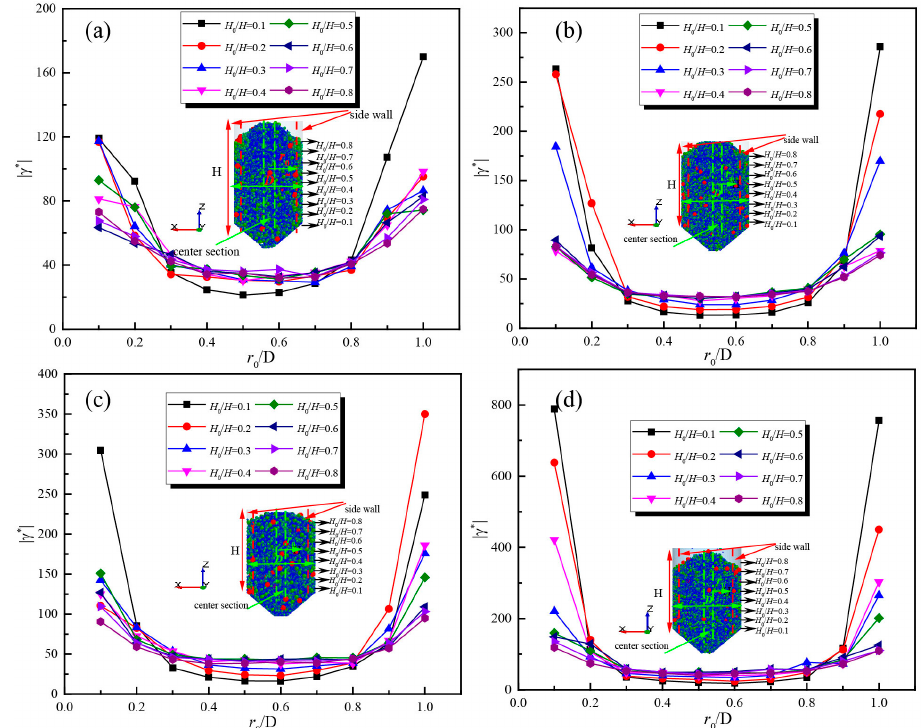
Figure 27. The variation in shear rate of sinter layers with variations in the geometry factor of VSCB of ( a ) D 0 / d p = 75, ( b ) D 0 / d p = 100, ( c ) D 0 / d p = 125, and ( d ) D 0 / d p = 150.